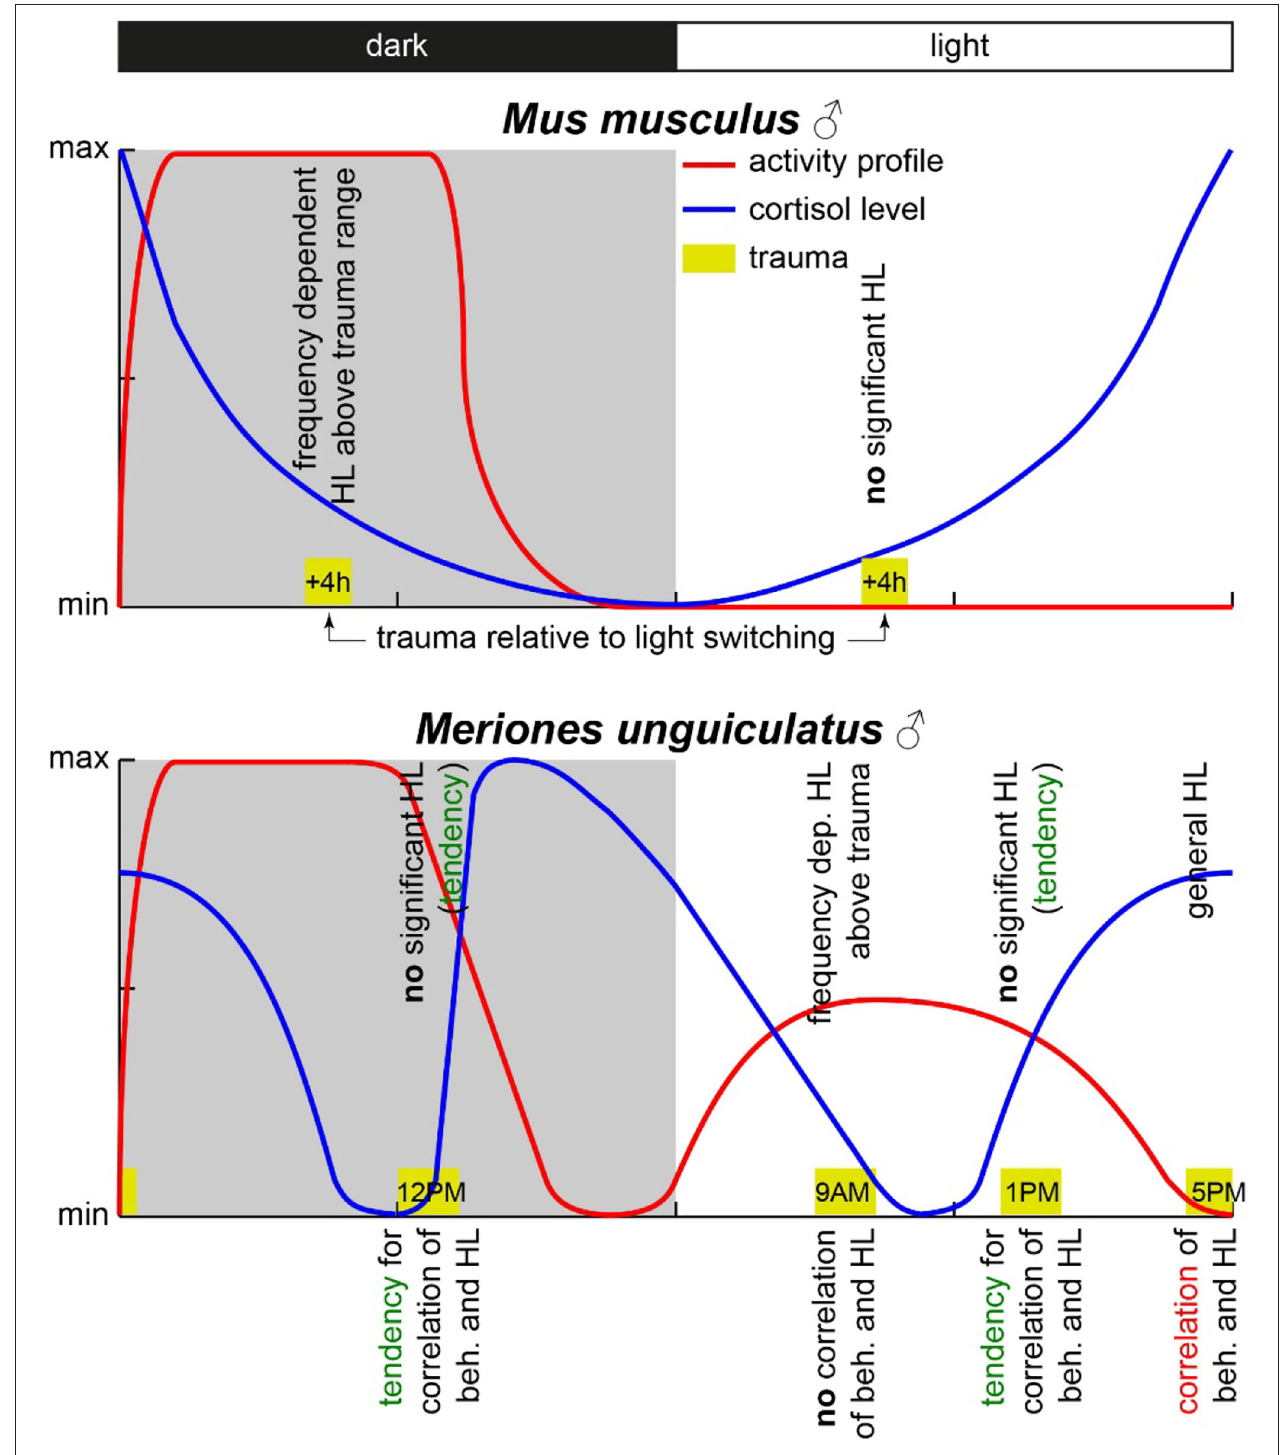
FIGURE 6 | Scheme of activity profiles and blood cortisol concentration in mice and Mongolian gerbils. The yellow boxes mark the times of trauma with the start times given inside. The observed HL effects are given above the trauma boxes, and the observed correlation between behavioral changes and HL is given below the respective trauma symbol. Data for this scheme are derived from (Roper, 1976; Saito et al., 1989; Valentinuzzi et al., 1997; Meltser et al., 2014; Hu et al., 2020) and this study.